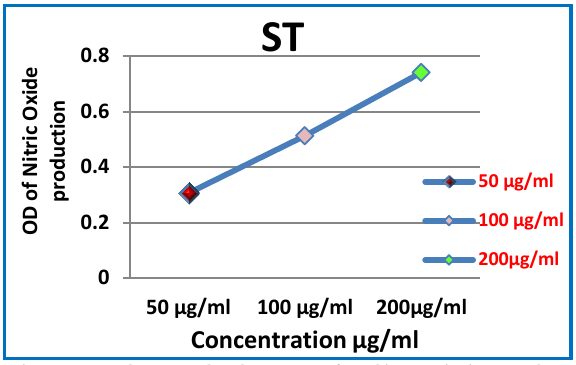
Figure, 1: The standard curve of sodium nitrite used to determine the Nitric oxide